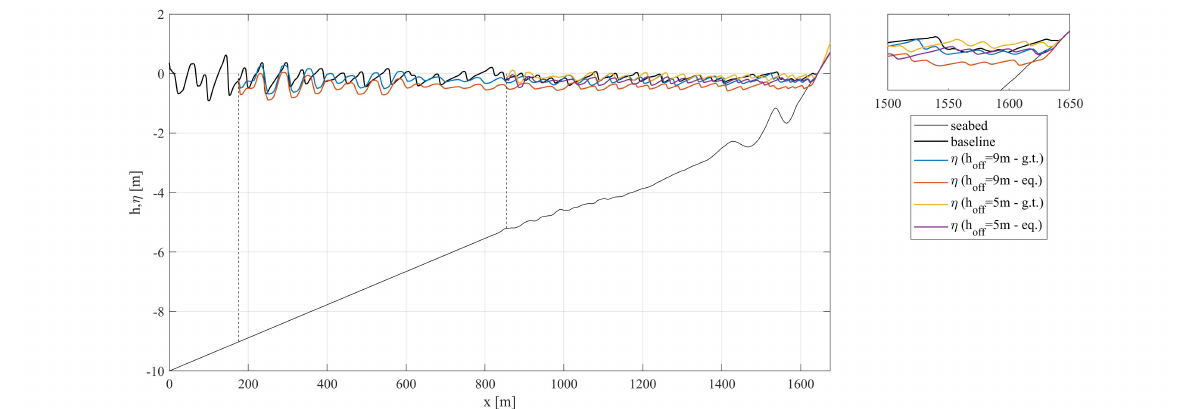
Figure 11. Cross-section of free-surface level at t = 1000 s ( ∼ 135 waves) for the NNE tests: baseline simulation (black thick line) vs. flood simulations (colored lines). The starting points of the flood simulations, corresponding to h ≈ 9 m and h ≈ 5 m, are also illustrated (vertical dashed lines). The little right panel shows a close-up view in the shallowest